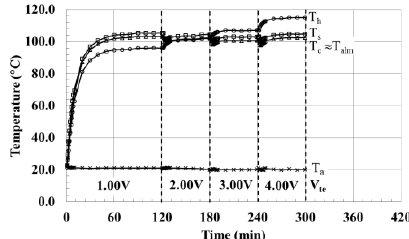
Figure 7. Transient temperatures for the FHS ‐ TE assembly (NC, P EH = 20 W, Run D2).